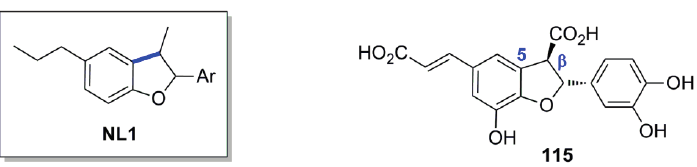
Figure 5. A neolignan ( 115 ) of the 2,3-dihydrobenzofuran type (NL1).